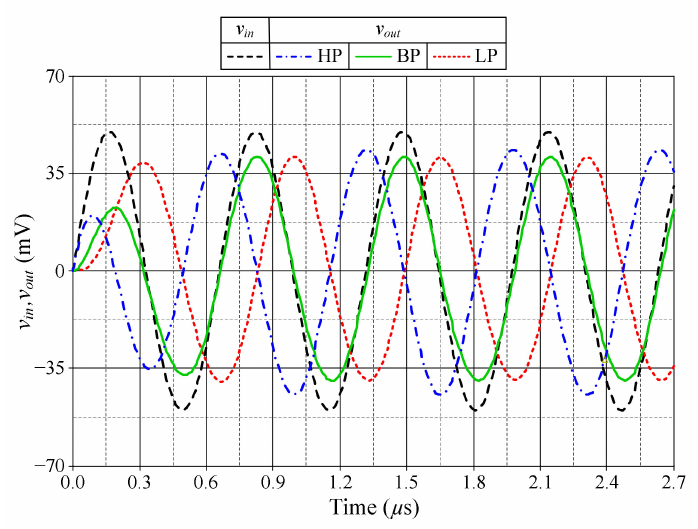
Figure 8. Transient analysis responses of the proposed filter in